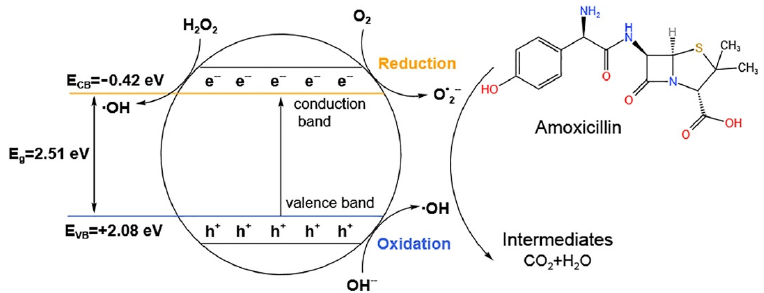
Figure 6. Schematic diagram of the degradation mechanism of the antibiotic amoxicillin over the modified Ce 0.04 Sr 0.96 Fe 0.04 Ti 0.96 O 3 photocatalyst. Reproduced with permission from Suwannaruang et al., Surf. Interfaces [123]; published by Elsevier, 2021.